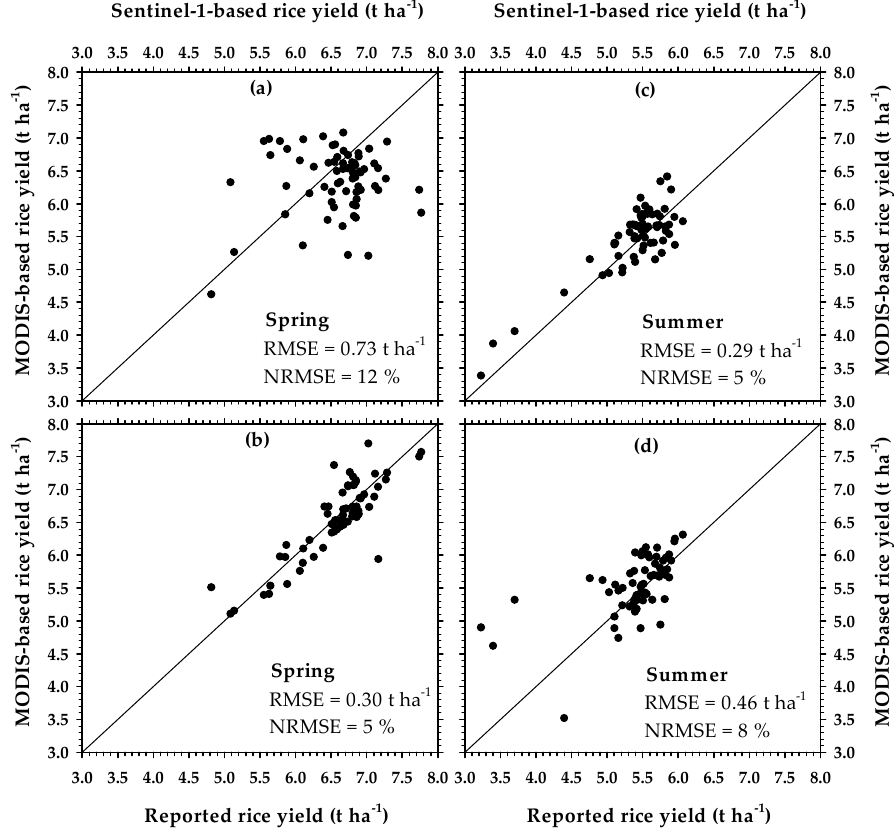
Figure 6. Scatter plot comparing rice yield aggregated at the district level as derived from: MODIS vs. Sentinel-1 ( a , c ); and MODIS vs. official source (reported) ( b , d ), for the 2016: spring ( a , b ); and summer ( c , d ) seasons in the Red River Delta of Vietnam. n = 66 districts. Table 3. Comparison between average rice yield (14% moisture content, MC) at provincial level derived from MODIS, SAR, and official source, for the 2016 summer and spring seasons in the Red River Delta of Vietnam.